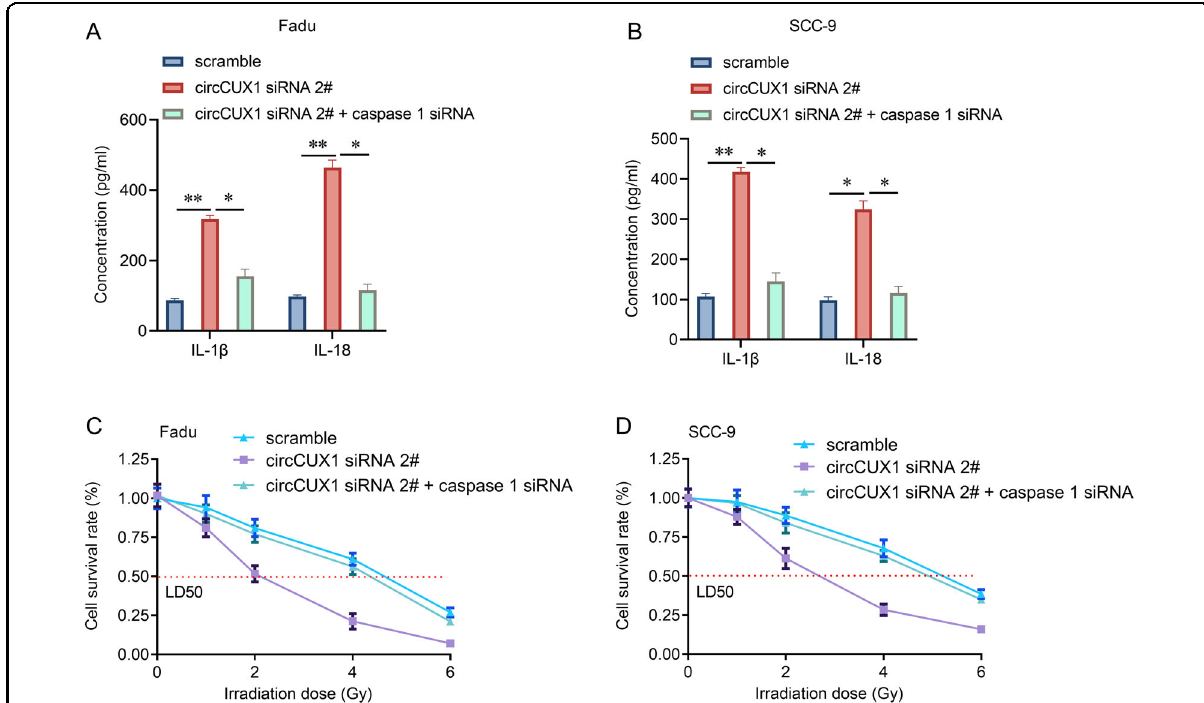
Fig. 7 CircCUX1 confers radioresistance of HPSCC through caspase1 pathway. A , B The concentration of IL-1 β and IL-18 was determined by ELIZA after siRNA transfection and irradiation in Fadu ( A ) and SCC-9 ( B ) cells. C , D CCK-8 assay for the cell survival rate after siRNA transfection and irradiation in Fadu ( C ) and SCC-9 ( D )